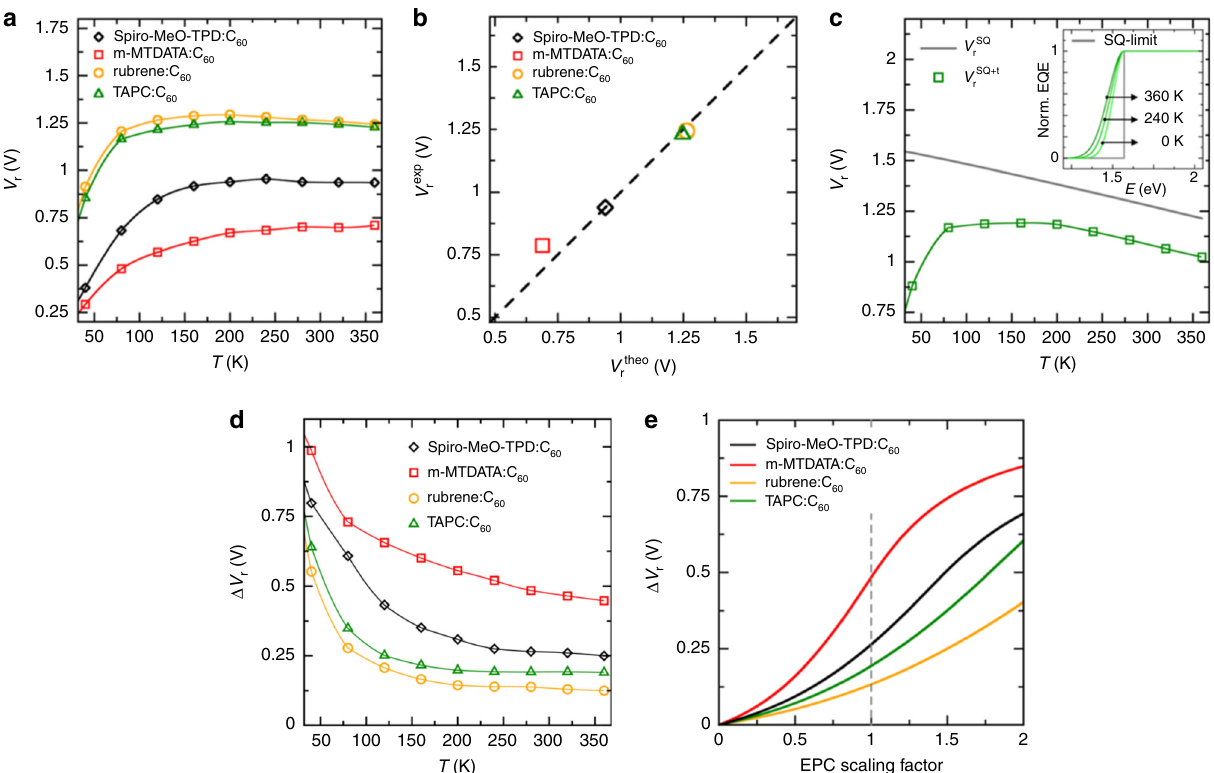
Fig. 3 Radiative limit of the open-circuit voltage and vibration-induced radiative voltage losses. a V r for different donor:C 60 blends based on the simulated EDOS D ( ω ) and the AM1.5G solar spectrum (Eq. 4). Donor species are indicated. b Comparison of theoretical and experimental V r at room temperature. Experimental room-temperature data are taken from ref. 54 . c Comparison of V SQ broadened SQ model based on the TAPC:C 60 tail (green). Inset: underlying absorption pro fi les (normalised EQE) for the SQ model (grey) and the model TAPC:C 60 blend (at 6 mol% donor) (green) whose additional Gaussian tail corresponds to the broadening σ ( T ) as calculated in Fig. 2b. In both models, E g = 1.57 eV of a TAPC:C 60 blend is used as gap energy. The voltage loss Δ V r = V SQ dependence of Δ V r for all donor:C 60 blends based on the broadening σ ( T ) from Fig. 2b. e Dependence of voltage losses Δ V r on the strength of the EPC for the different systems ( T = 300 K). Dashed grey line indicates the reference Δ V r for the microscopic EPC parameters from ab initio simulations and E g = E 1 (i.e. the peak energy of the CT absorption) is taken for the individual system. In a , c and d are the lines guide to the CT